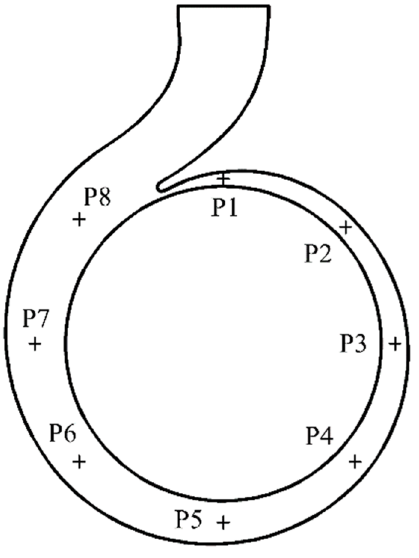
Figure 17. Distribution of the pressure pulsation monitoring points.